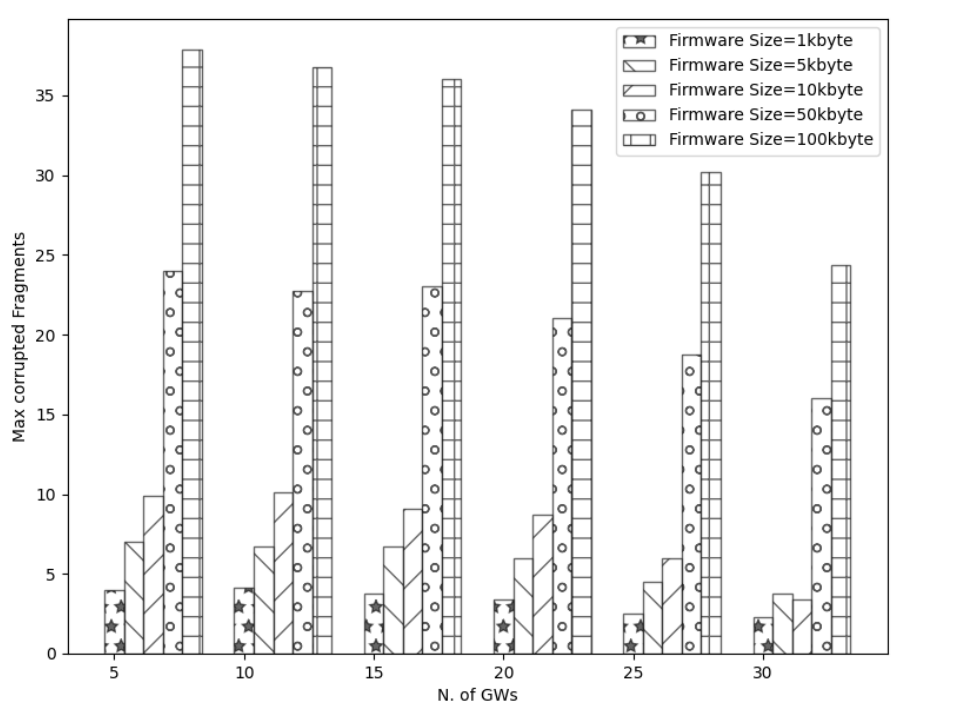
Figure 6. Effect of multiple GWs and firmware size in corrupted